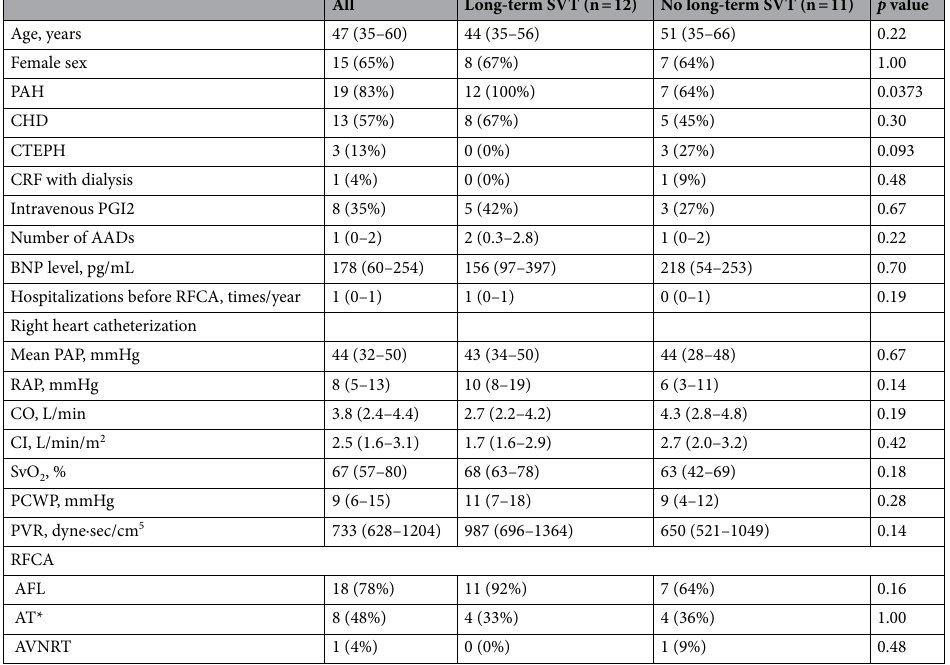
Table 1. Baseline characteristics according to the presence or absence of SVT after the last RFCA procedure. AAD antiarrhythmic drug, AF: atrial fibrillation, AFL: common atrial flutter, AT: atrial tachycardia, AVNRT: atrioventricular nodal reentrant tachycardia, BNP: brain natriuretic peptide, CHD: congenital heart disease, CI: cardiac index, CO: cardiac output, CRF: chronic renal failure, CTEPH: chronic thromboembolic pulmonary hypertension, PAH: pulmonary arterial hypertension, PAP: pulmonary artery pressure, PCWP: pulmonary capillary wedge pressure, PG: prostaglandin, PVR: pulmonary vascular resistance, RAP: right atrium pressure, RFCA: radiofrequency catheter ablation, SvO 2 : mixed venous oxygen saturation, SVT: supraventricular tachycardia. *AT did not include non-sustained AT in this